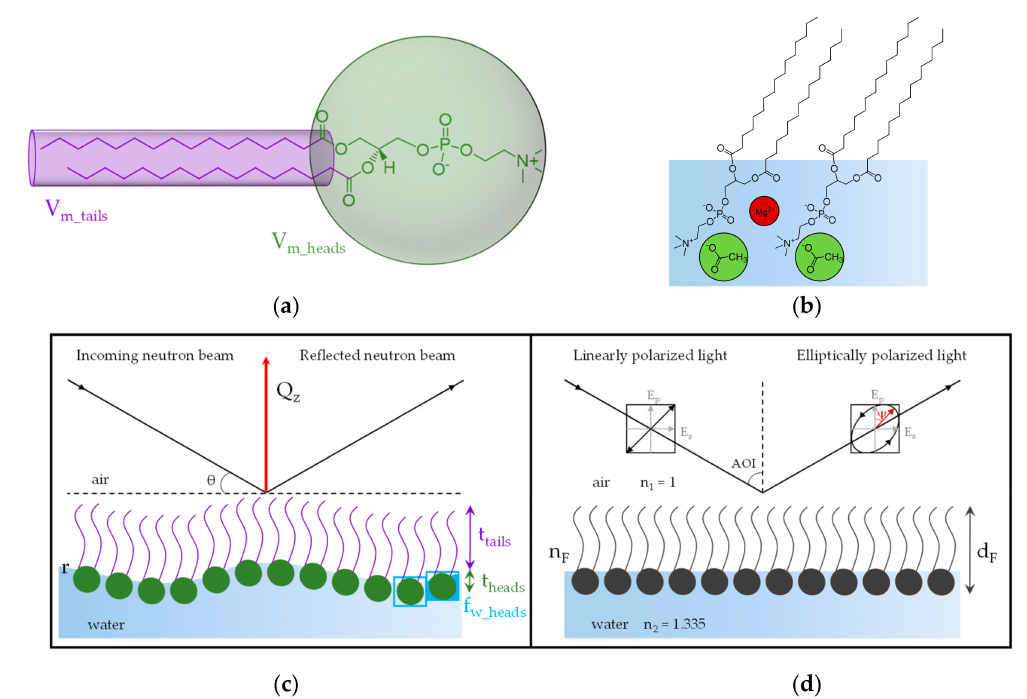
Figure 1. ( a ) Structure formula of DPPC. The polar headgroup is depicted in green and the hydrophobic tails in violet following a two-layer model proposed in the main text. A green sphere and a violet cylinder are drawn to better show V m_heads and V m_tails , respectively. ( b ) The scheme representing the main electrostatic interactions between the phospholipids molecules with the ions composing the bu ff er: the magnesium cation is depicted as a red sphere, while the acetate anion is depicted as a green sphere. We deduce that these interactions have an influence on DPPC monolayer structure. Bottom panel compares neutron reflectometry ( c ) and ellipsometry ( d ) principles of measurement. In the case of NR, a two-layer model can be exploited in order to get both the thickness of the headgroups ( t heads ) and the one of the tails ( t tails ); indeed, the two-layer model is shown, depicting the heads in green and the tails in violet. Moreover, NR also gives information about the fraction of water per polar headgroup ( f w_heads ) and the roughness of the interfaces ( r ), whose value depends on the water capillary waves. The angle of incidence of the neutron beam ( θ ) and the scattering vector, or momentum transfer, ( Q Z ) are shown. On the other hand, ellipsometry does not disentangle the contribution of the headgroup and the aliphatic chains to the thickness as NR. In addition, the roughness is considered to be equal to zero (as an ideal interface). The incoming and the reflected light beams, whose electric field is divided in parallel ( E p ) and perpendicular ( E s ) components, are shown. Besides, the angle of incidence (AOI) and the ellipsometric angle Ψ are